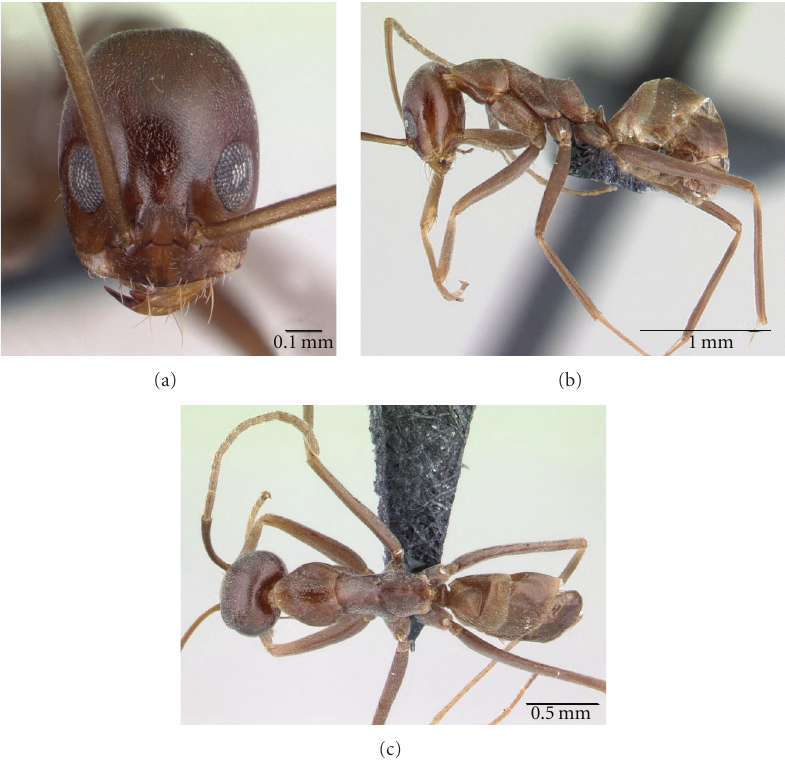
Figure 8: Dorymyrmex goeldii worker. (a) Head in full-face view; (b) body in lateral view; (c) body in dorsal view (CASENT0192699). Pictures and labels of localities of each photographed specimen are available at http://www.antweb.org/.